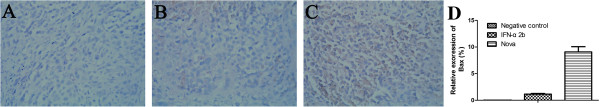
The immuno histochemical analysis result of Bax in each group. Bax protein increased in tumor tissues after mice was treated by IFN-α2b (B) and Nova (C) compared with the negative control (A). D is quantization of the expression of the proteins evaluated in the different samples with immunohistochemistry.